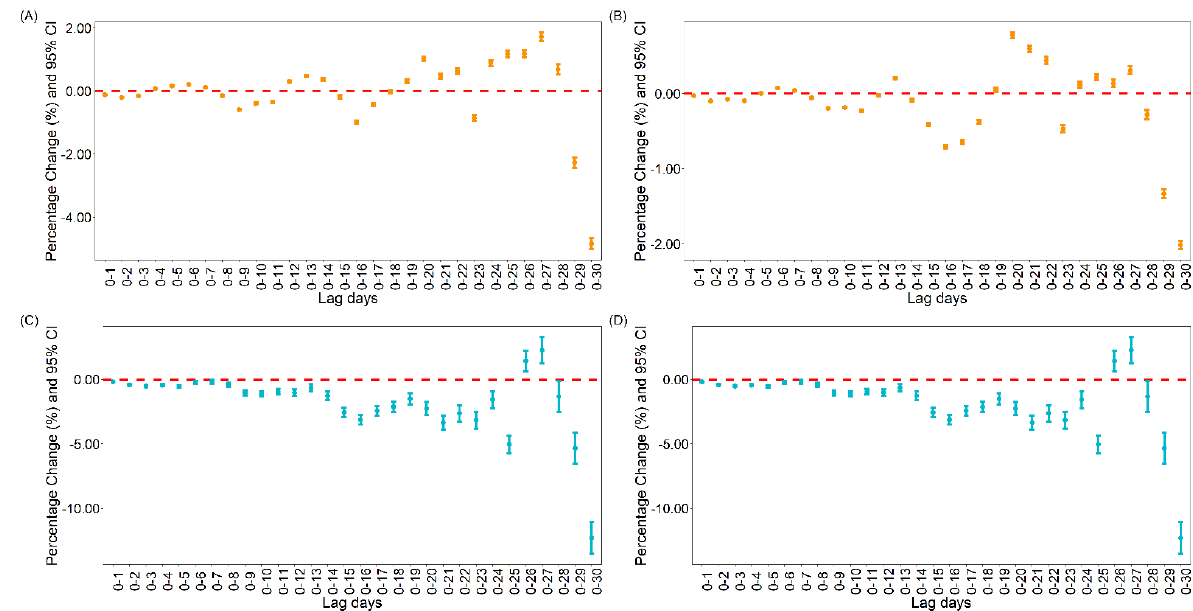
Figure 2. Percentage change in daily cases and deaths with moving lag in the US. ( A ) Percentage change of daily cases with daily 10,000 people fully vaccinated increasing; ( B ) Percentage change of daily cases with daily 10,000 people vaccinated increasing; ( C ) Percentage change of daily deaths with daily 10,000 people fully vaccinated increasing; ( D ) Percentage change of daily deaths with daily 10,000 people vaccinated increasing.